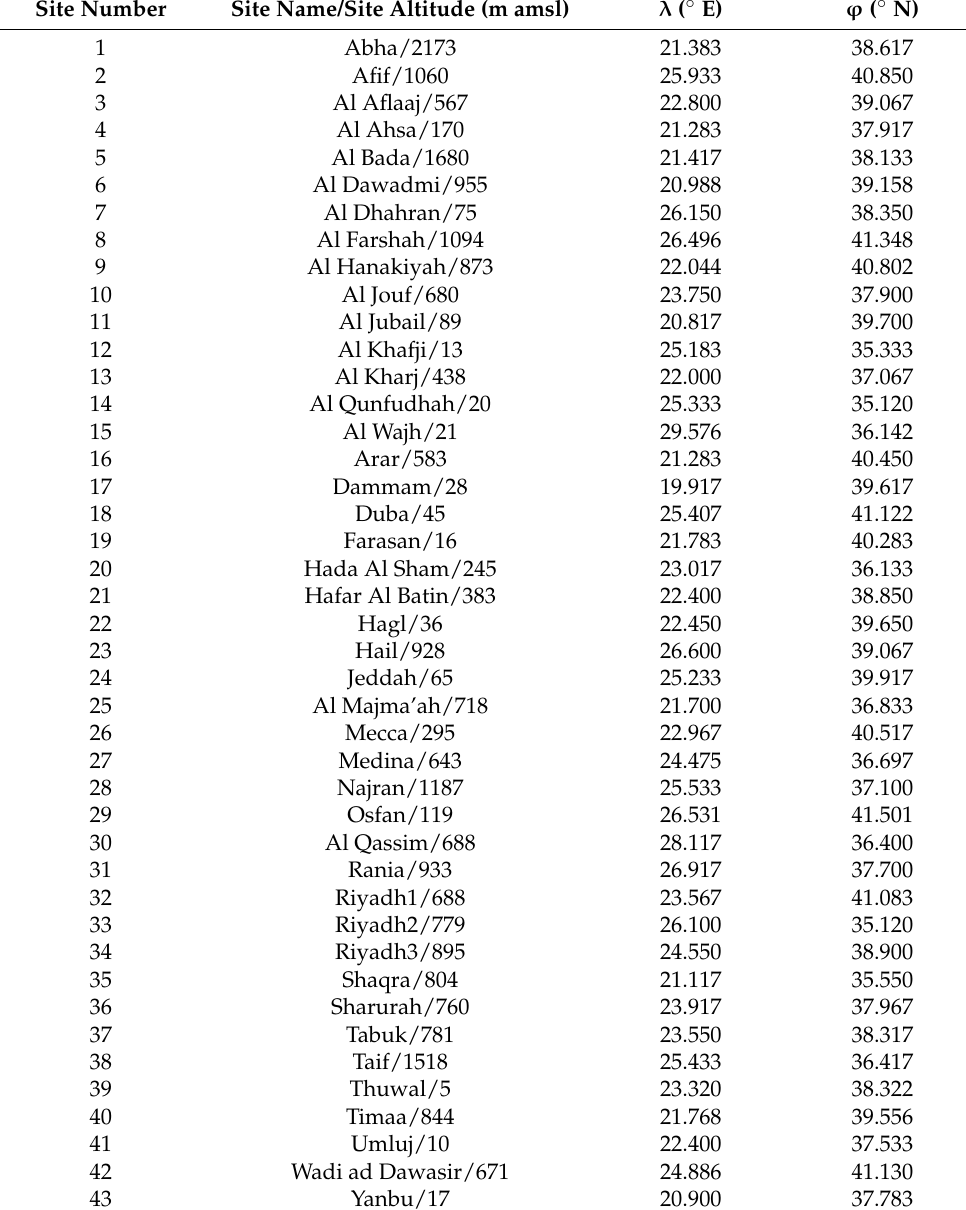
Table 1. The 43 sites involved in the study. The names of the locations are given in alphabetical order. The geographical longitude, λ ; and the geographical latitude, ϕ , are in degrees ( ◦ ); E = east of the Greenwich meridian; N = northern hemisphere; amsl = above mean sea